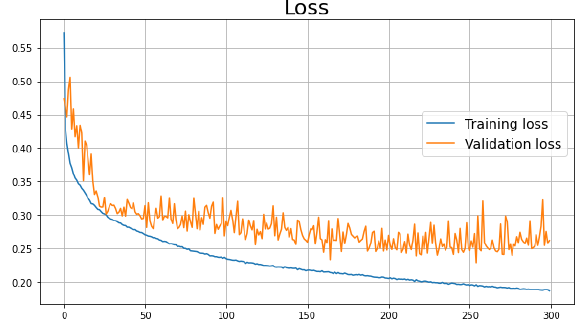
Figure 5. Loss graph for the training process on the combined